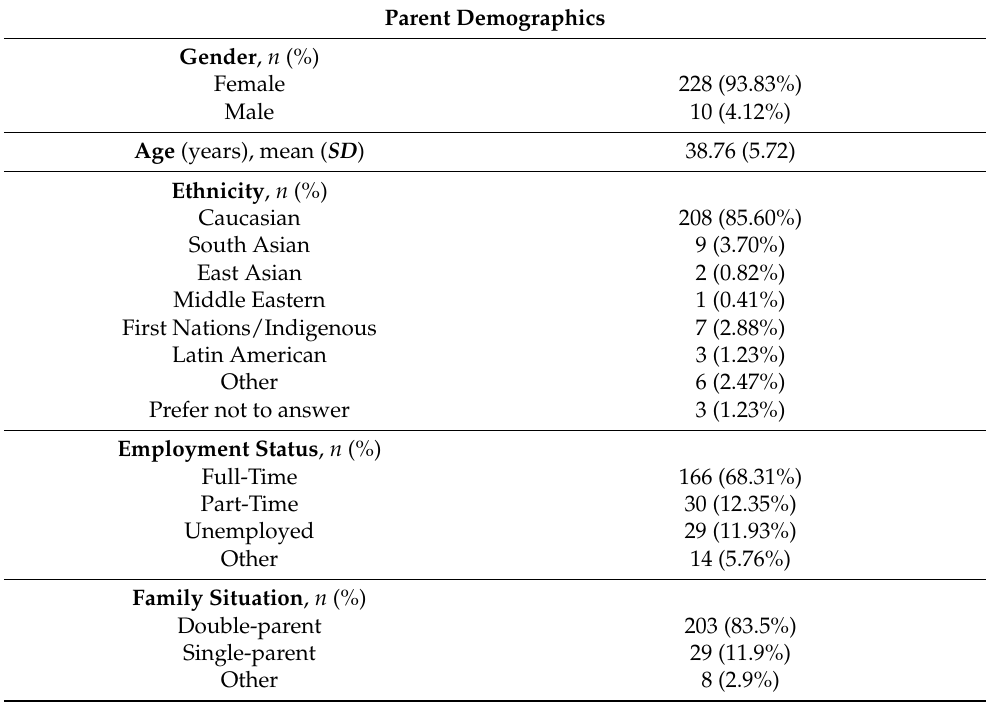
Table 1. Demographic Information of Parents ( n = 243) and their Children ( n =